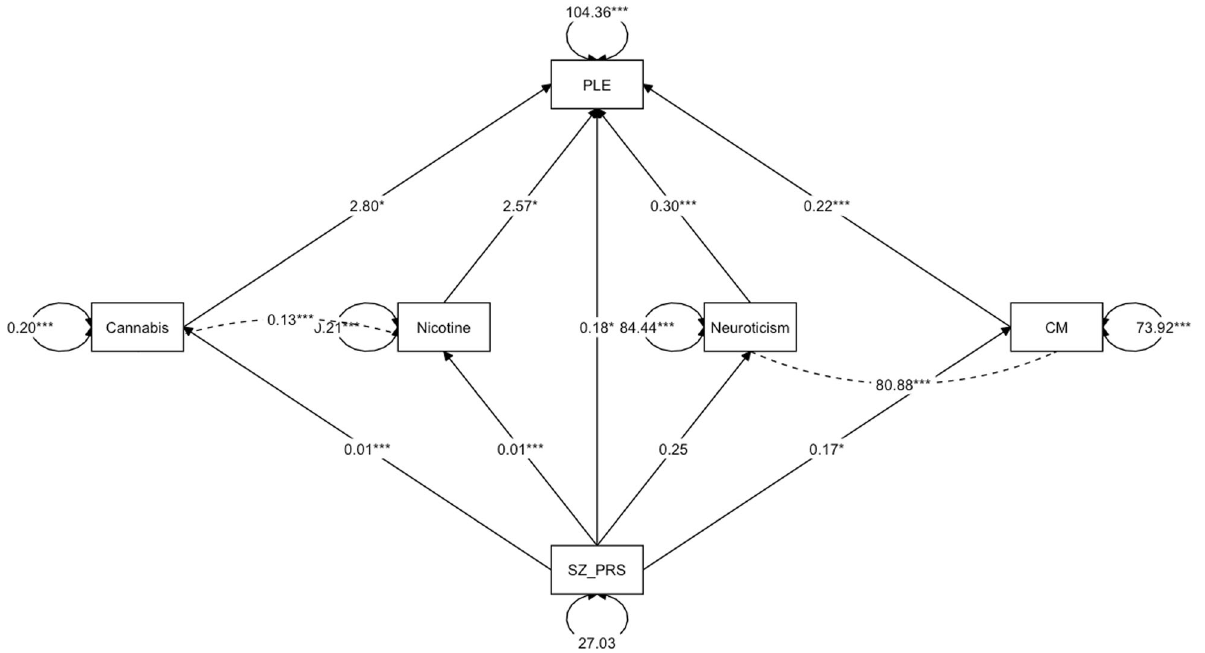
Fig. 2 Path diagram of parallel four-mediator model in the discovery sample (UCC). The estimates reported are the unstandardized regression coef fi cients. * p < 0.05; ** p < 0.01; *** p < 0.001. SZ-PRS schizophrenia polygenic risk score at p value threshold 0.5, CM childhood maltreatment, PLE psychotic-like